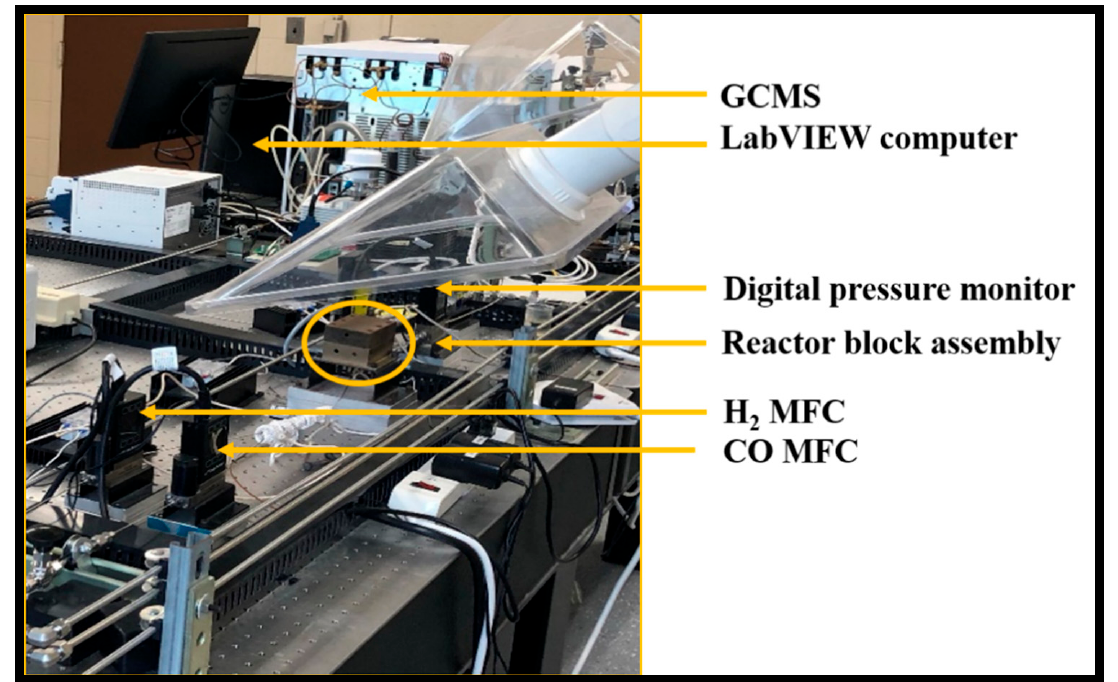
Figure 3. Experimental setup used for Fischer–Tropsch synthesis, using Si-microchannel microreac- tor [23] (microchannel dimensions: 2.4 cm long × 50 µm wide × 100 µm deep) .